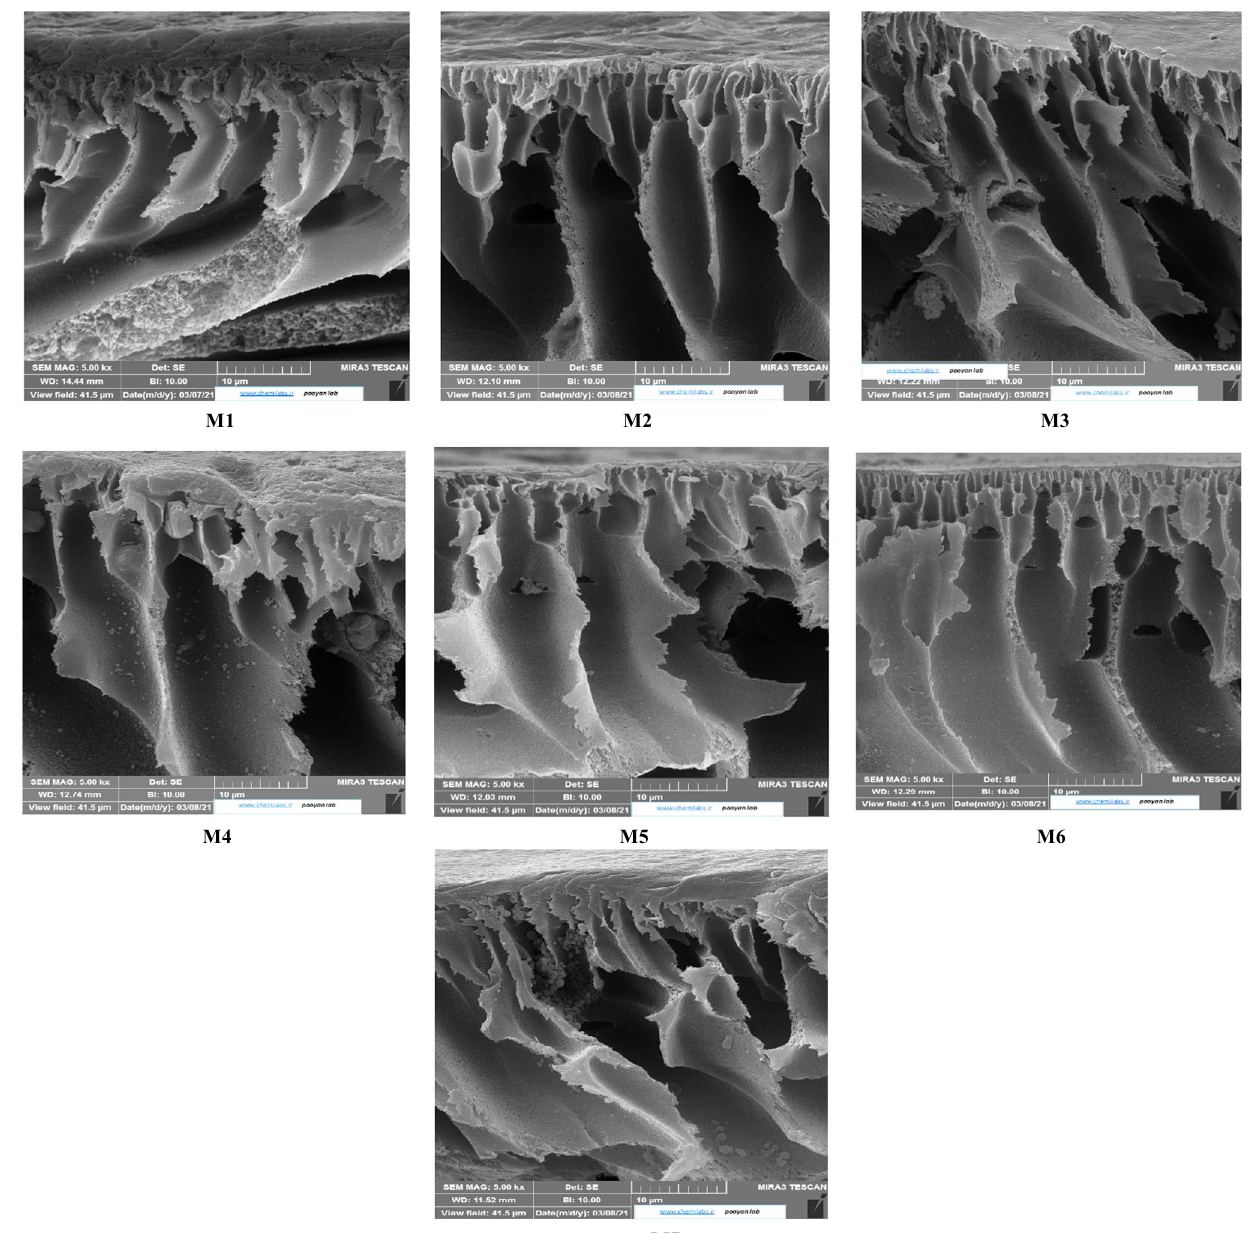
Fig. 2 FESEM images of the fabricated